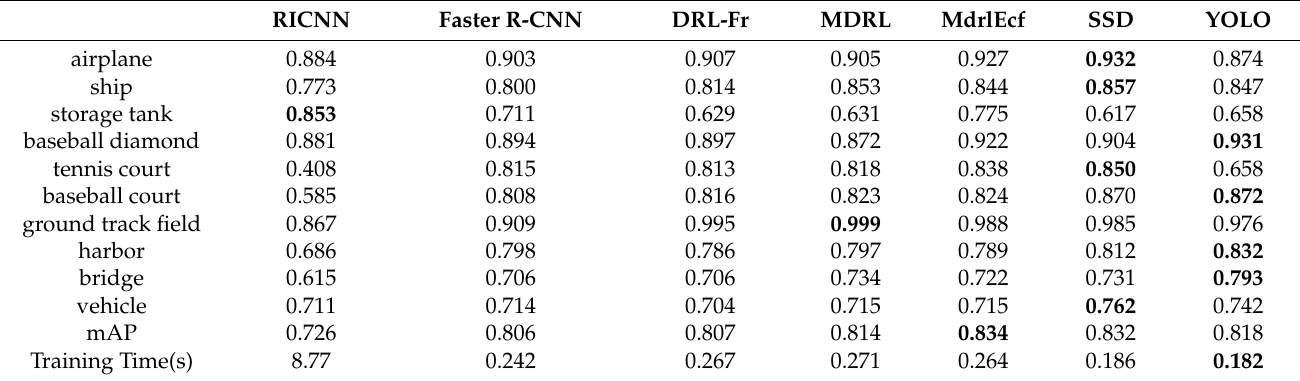
Table 3. Comparison of detection accuracy of different models on the NWPU VHR-10 dataset.